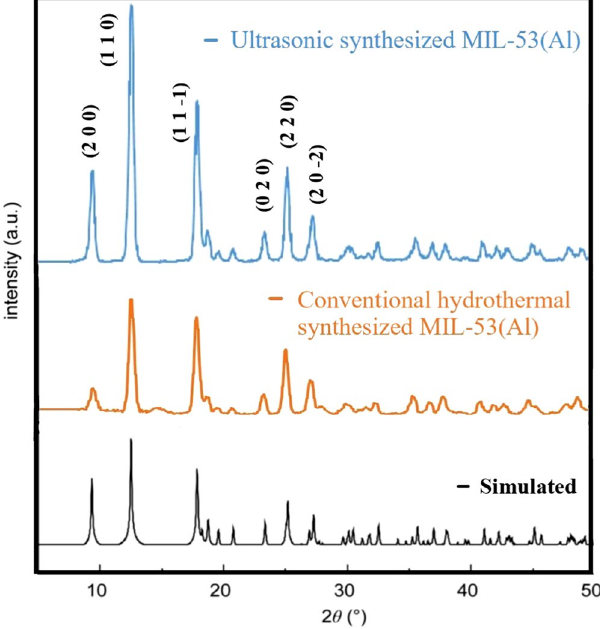
Figure 1. X-ray diffractograph of the ultrasonic and the conventional synthesized